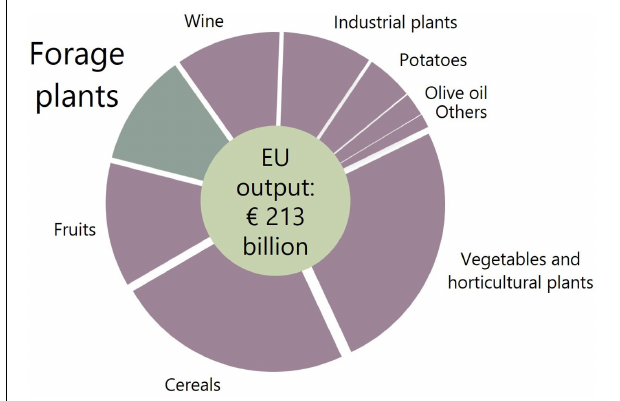
FIGURE 1 | Total European Union output for all crops in 2016 from Eurostat data (Helminger et al., 2016). This includes a substantial portion for forage crops, comparable to the production of fruits and